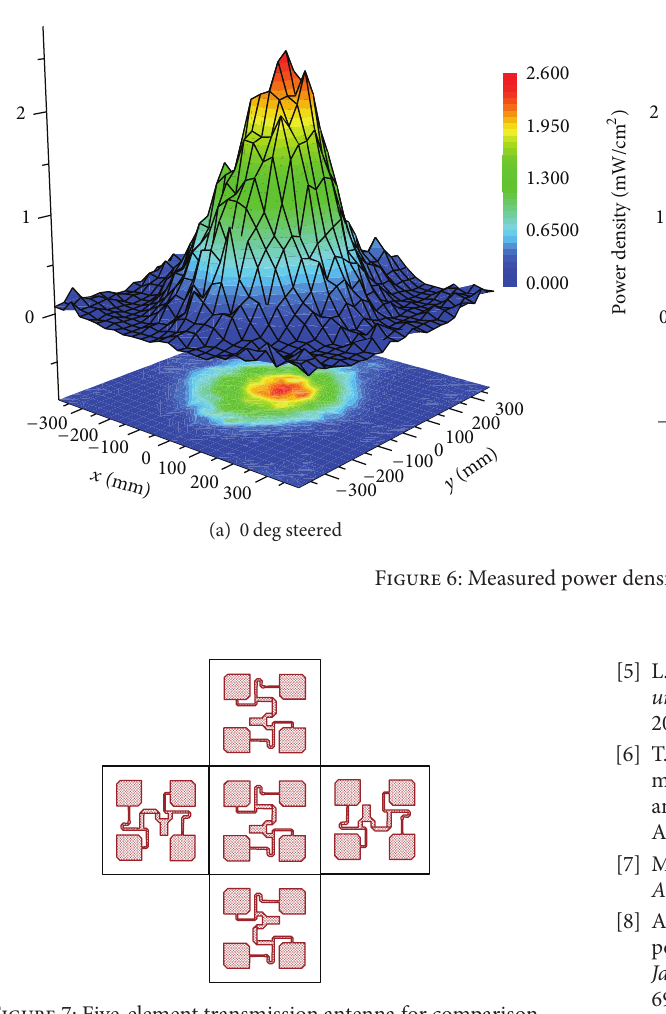
Figure 7: Five-element transmission antenna for